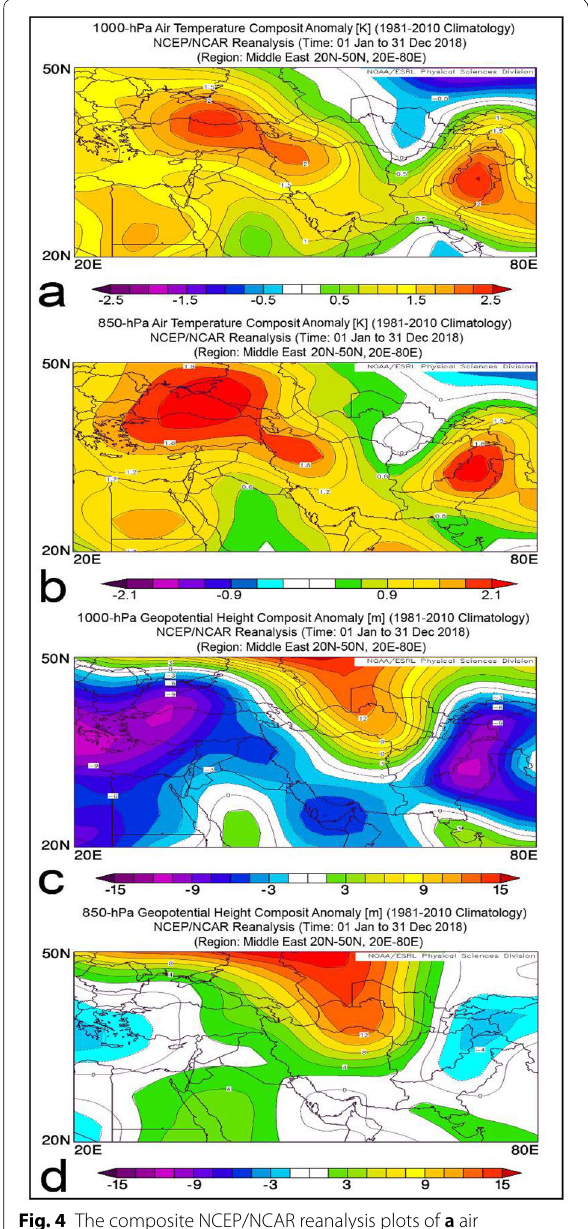
Fig. 4 The composite NCEP/NCAR reanalysis plots of a air temperature anomaly at the level of 1000 hPa, b air temperature − anomaly at the level of 850 hPa, c geopotential height anomaly at − the level of 1000 hPa, and d geopotential height anomaly at the − level of 850 −